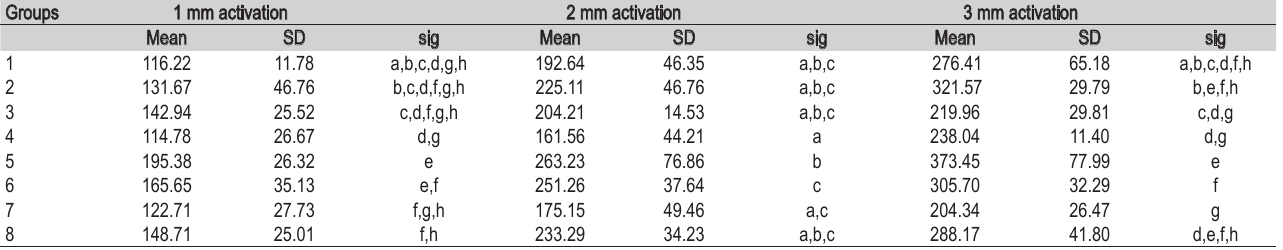
Table 1 - Mean and standard deviation loads (gf) in three-point bending tests, stratified by brand and presence of aesthetic coating. Groups